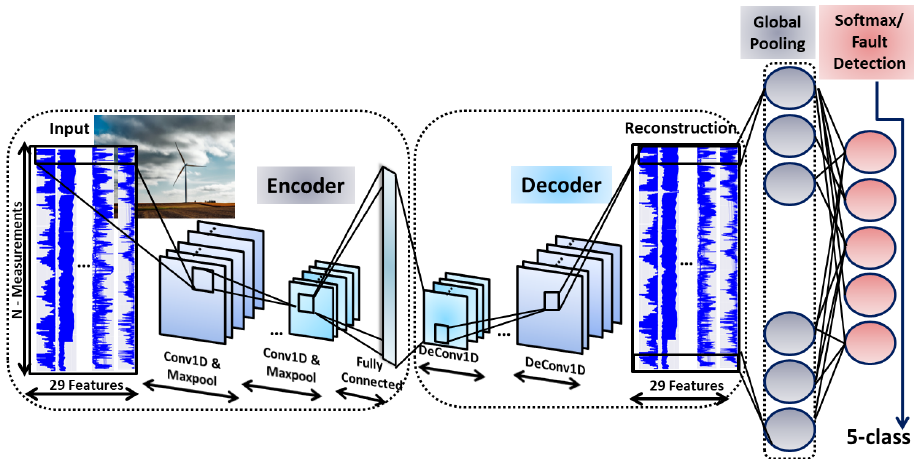
Figure 2. Convolutional Neural Network-Stacked Autoencoders (CNN-SAE) Architecture for Wind Turbine Fault Dection: In this scenario, we exploit a Stacked Autoencoders scheme, using multiple Convolutional and Max Pooling Layers. According to the basic scheme of the autoencoders, the output layer of the CNN-SAE architecture, that is, reconstruction layer is approximately equal with the input layer, while it classifies the learnt representations into the corresponding normal/fault categories.